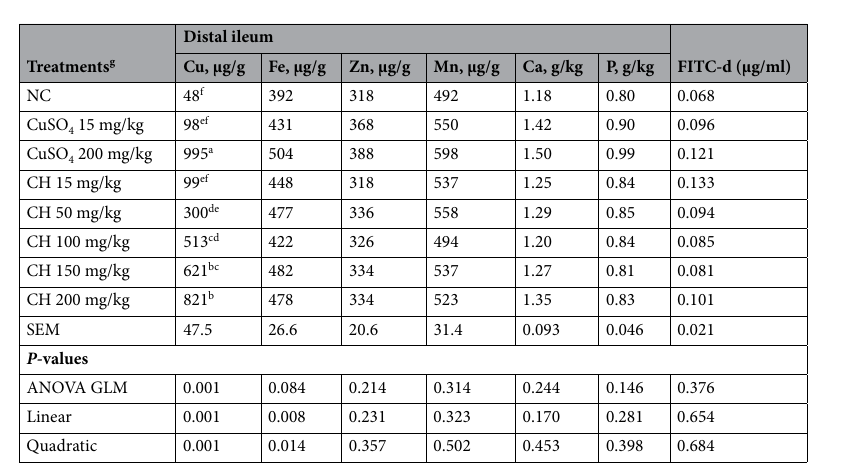
Figure 1. Histological representation of the jejunum in broilers (scale bar: 100 µm). Villus height (black line) was measured from the tip of the villi to the villus-crypt junction (yellow line); Crypt depth (blue line) was measured on the depth of invagination between adjacent villi. T1: NC diet, containing no supplemental Cu; T2: containing 15 mg/kg Cu as CuSO 4 ; T3: containing 200 mg/kg Cu as CuSO 4 ; T4: containing 15 mg/kg Cu as Copper hydroxychloride; T5: containing 50 mg/kg Cu as Copper hydroxychloride; T6: containing 100 mg/kg Cu as Copper hydroxychloride; T7: containing 150 mg/kg Cu as Copper hydroxychloride; T8: containing 200 mg/ kg Cu as Copper hydroxychloride.